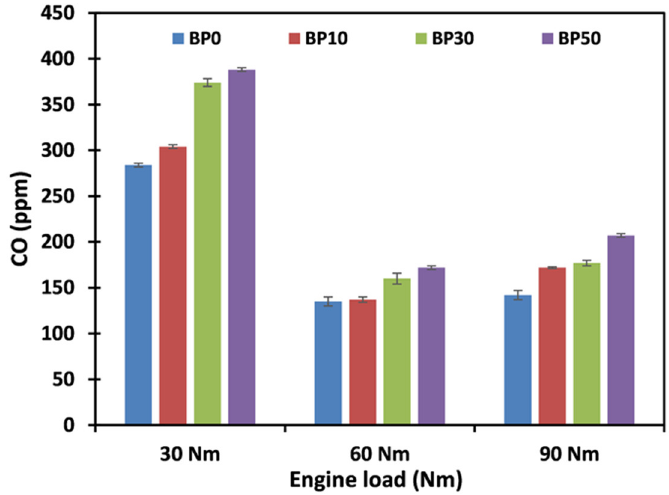
Figure 8. CO emissions for all test fuels according to various engine loads.